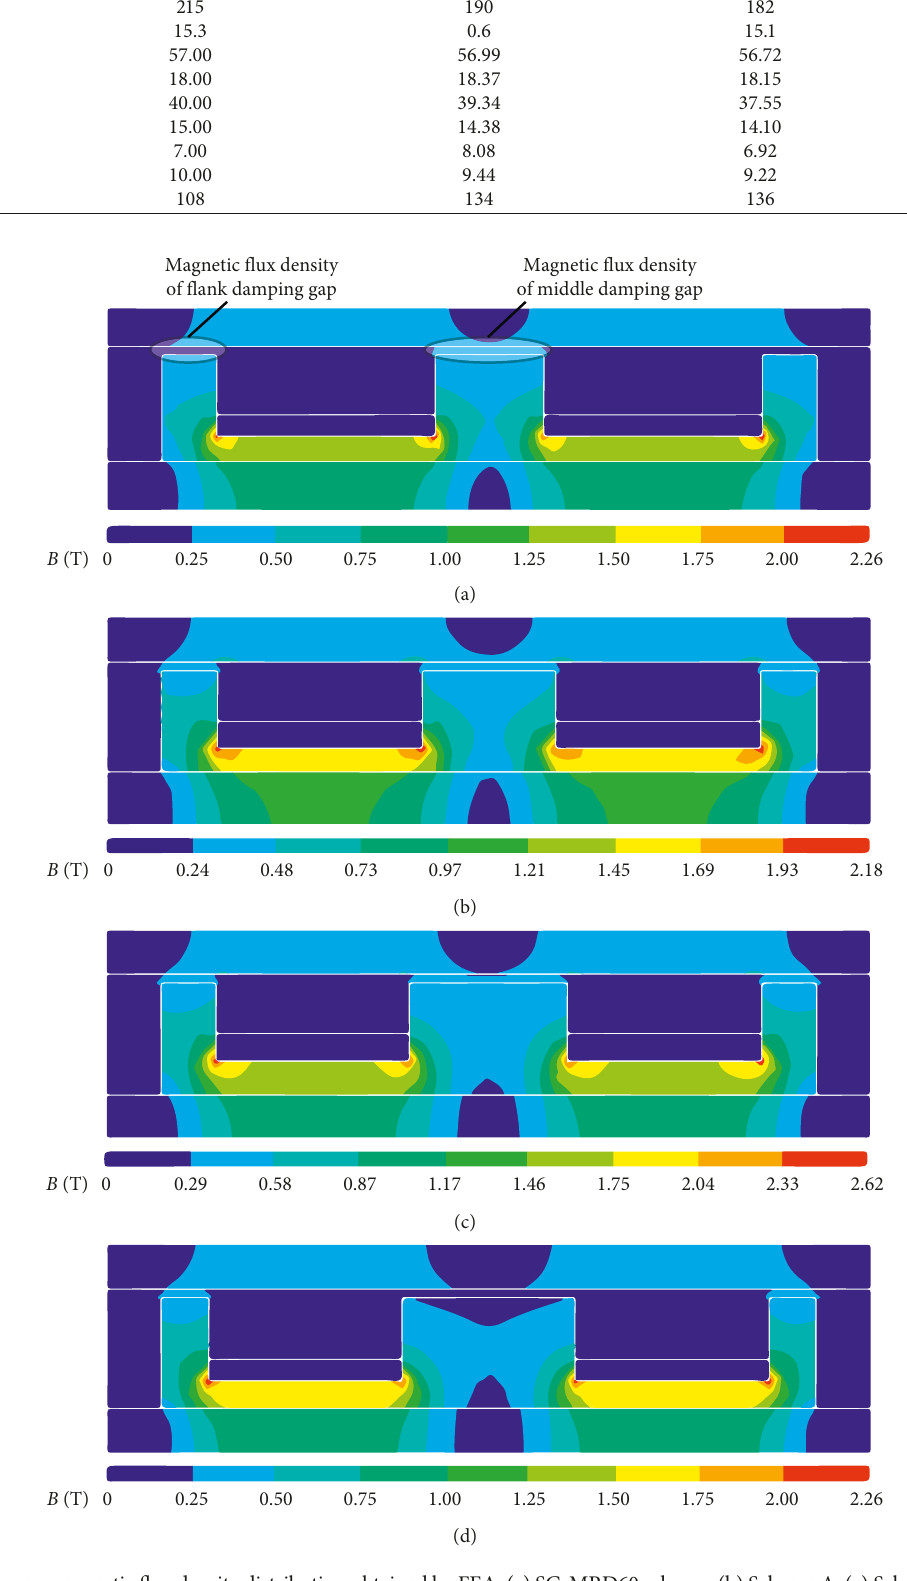
Figure 13: Nephogram magnetic flux density distribution obtained by FEA. (a) SG-MRD60 scheme. (b) Scheme A. (c) Scheme B. (d) scheme